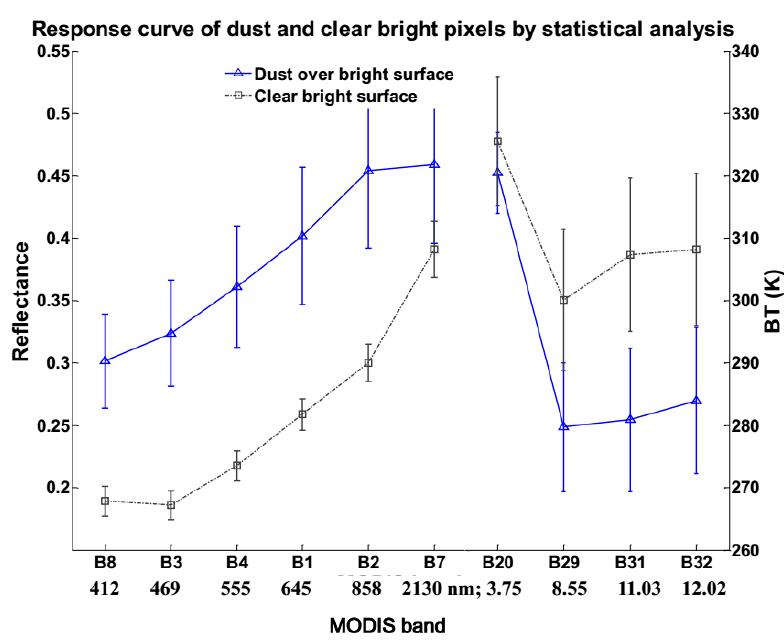
Figure 3. Response curves of dust and clear bright pixels.